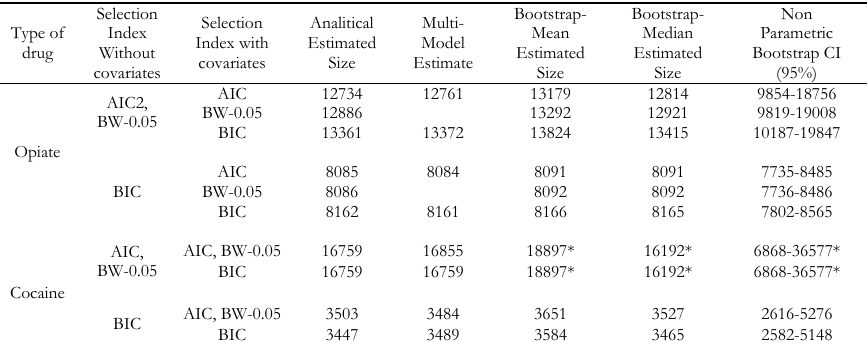
Analysis with covariates (Analytical, Multi-Model and Bootstrap estimates)